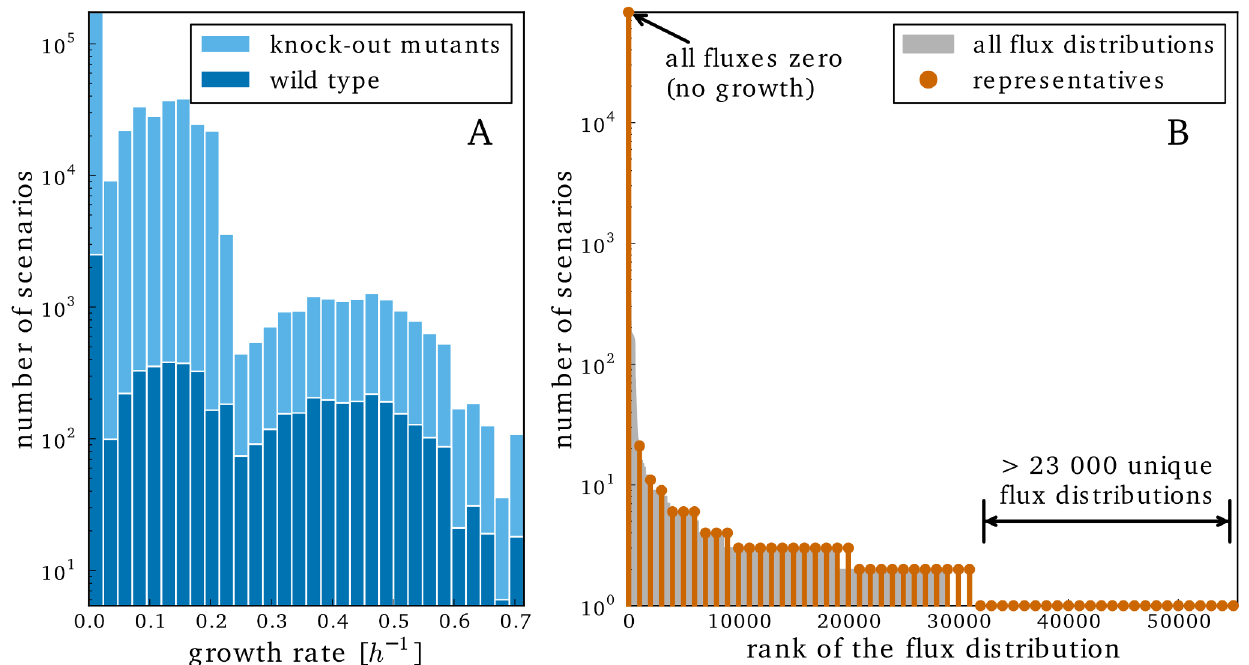
Figure 2. High-level overview of all simulations. A) Histogram showing the distribution of growth rates over all simulations. B) Number of simulations displaying a given flux distribution ranked by the number of simulations. For clarity, every 1000th flux distribution was chosen as representative. doi:10.1371/journal.pcbi.1003224.g002 PLOS Computational Biology |